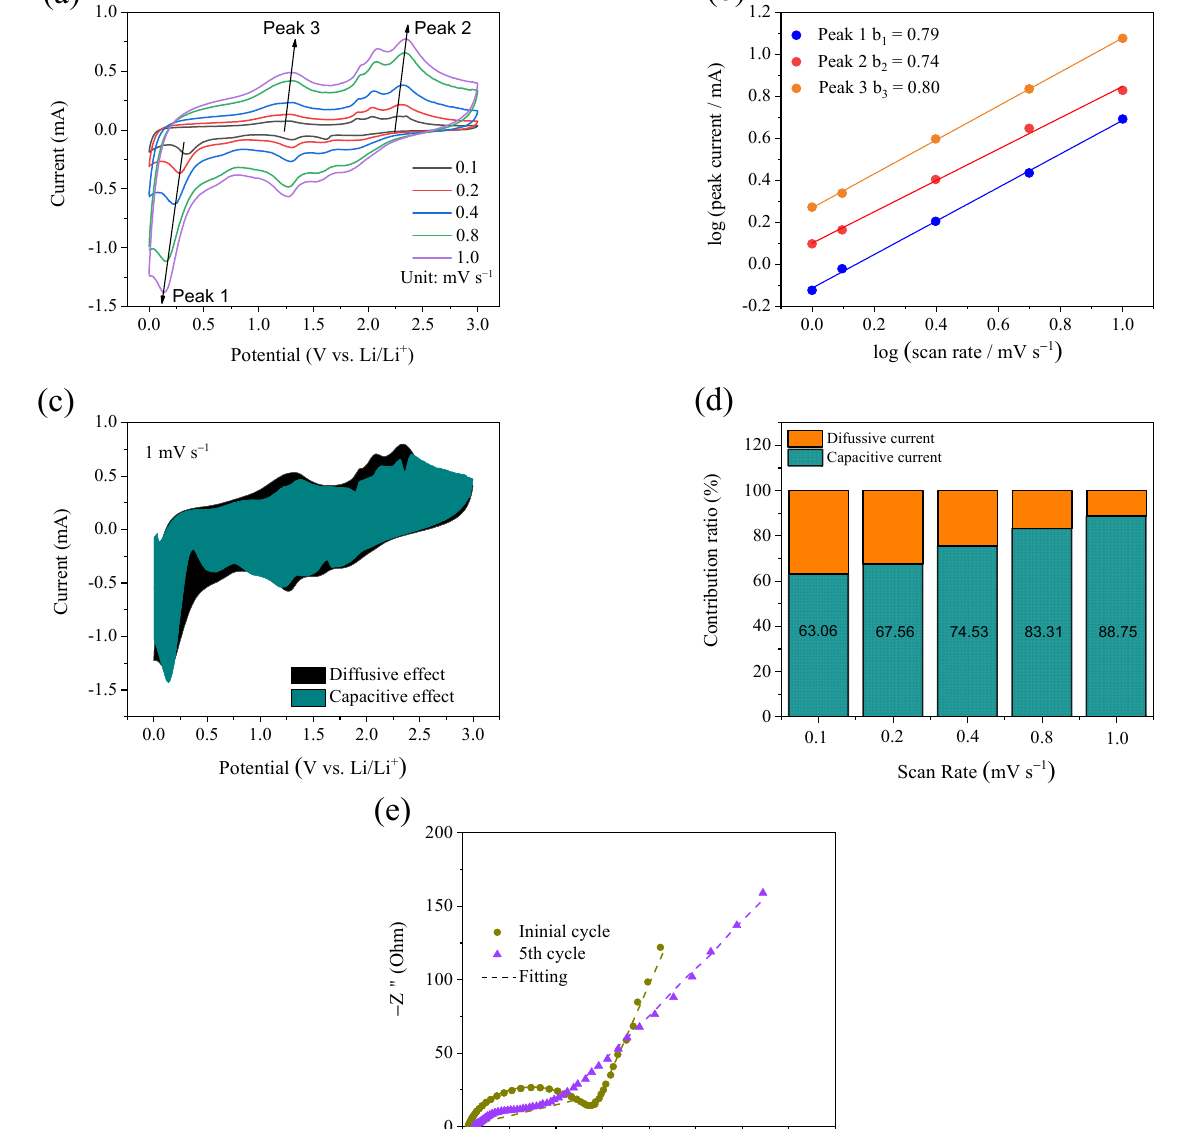
Figure 7. ( a ) CV curves of MnS@CoS/C@C at scan rates of 0.1, 0.2, 0.4, 0.8 and 1.0 mV s − 1 , ( b ) linear fitting of log ( i ) vs. log ( v ) of three oxidation/reduction peaks, ( c ) capacitive contribution (green region) and diffusive contribution (black region) to charge storage at scan rate of 1.0 mV s − 1 , ( d ) the normalized contribution ratios of the capacitive effect at different scan rates and ( e ) Nyquist plots and the fitting curves before cycling and after 5 cycles, with the equivalent circuit model.